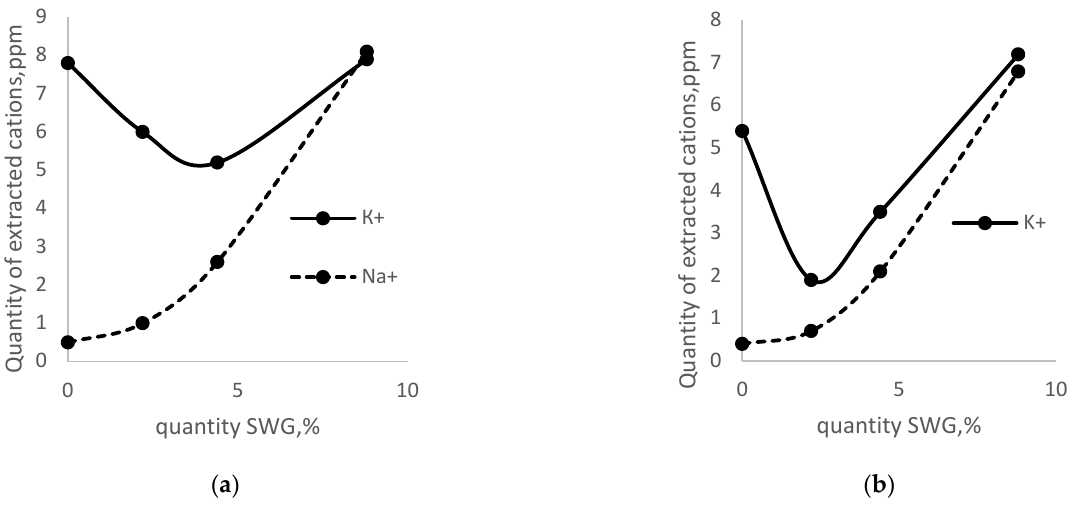
Figure 1. The amount of extracted cations depends on the amount of addition of sodium water glass: ( a ) after 24 h, ( b )—after 48 h.